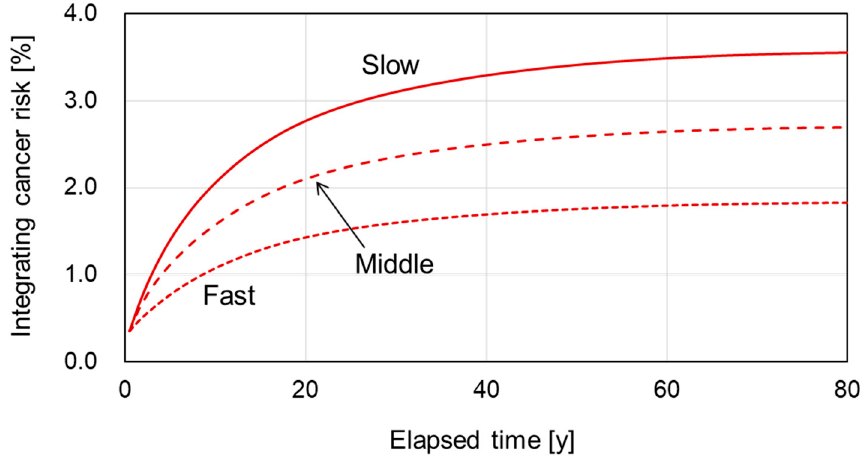
Figure 3. Predicted integrated cancer-mortality risk induced by γ -rays from 137 Cs deposited onto ground for a female infant (0 years old) at the initial dose rate of 20 mGy y − 1 . Table 3. Integrated cancer risks of a female person for three periods at the areas having different land-surface properties with the initial dose rate of 20 mGy y − 1